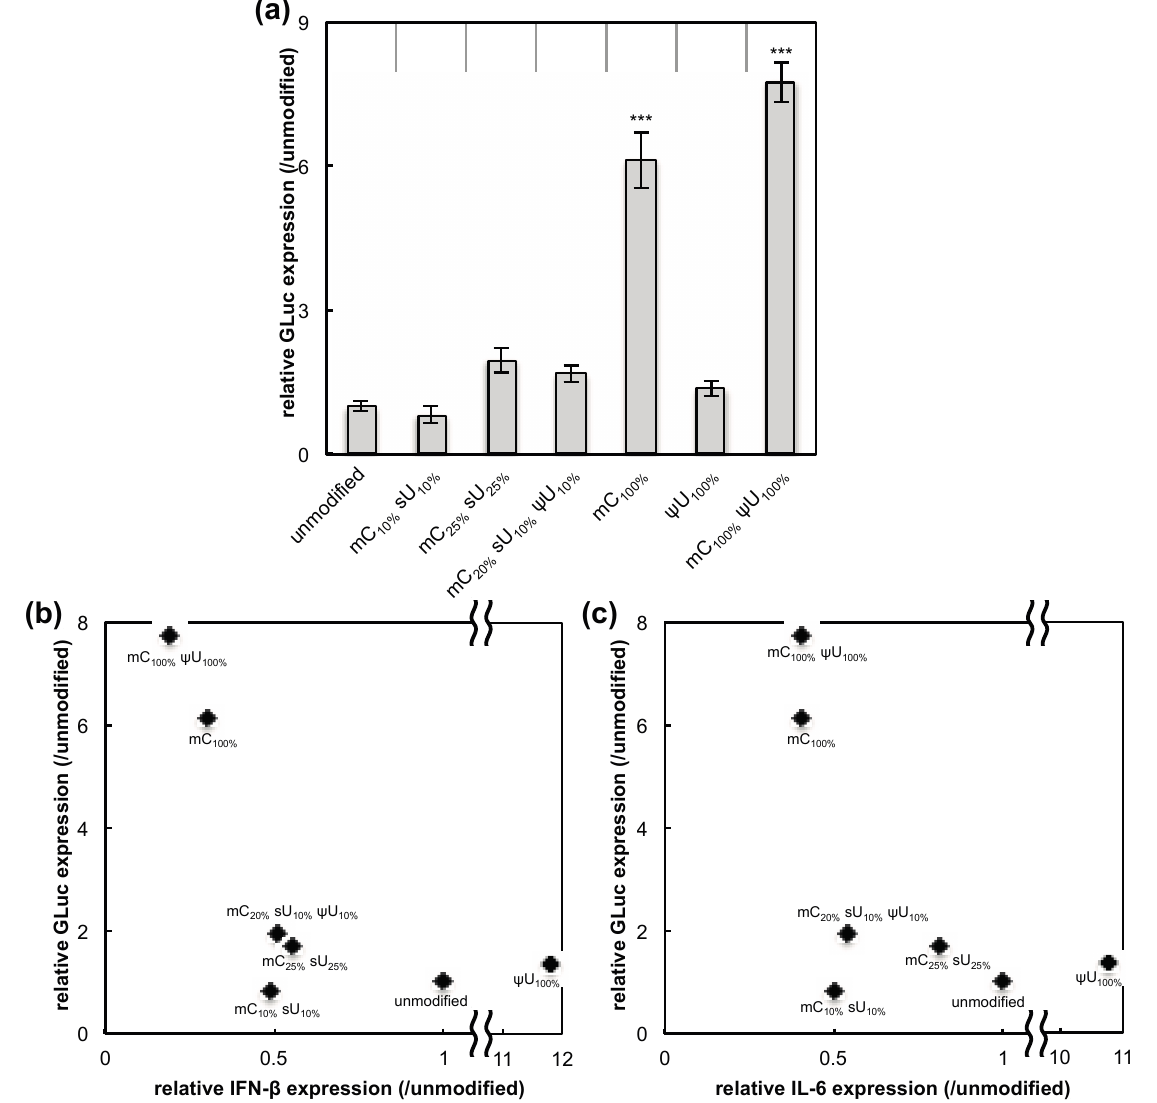
Figure 2. GLuc expression in RAW264.7 cells. mRNA-encoding GLuc was introduced to RAW264.7 cells using Lipofectamine™ LTX. After 4 h, the amount of GLuc protein in culture media was measured. ( a ) Efficiency of GLuc expression. The graph shows relative values compared to GLuc expression after transfection of unmodified mRNA. Data are presented as the mean ± standard error of the mean (S.E.M.) ( N = 6). Statistical significance was assessed by one-way analysis of variance (ANOVA) followed by Dunnett’s